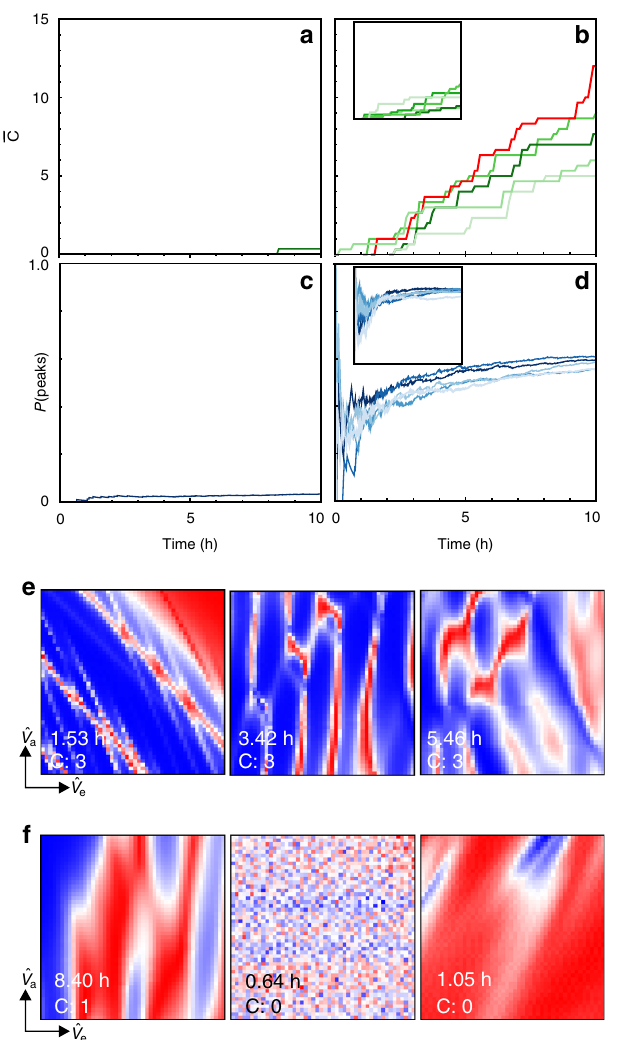
Fig. 5 Algorithm ’ s performance. a – d Average number of current maps displaying double quantum dot features, (cid:2) C , and P (peaks) as a function of laboratory time. Current maps are labelled by humans a posteriori, i.e., after the algorithm is stopped. a , c , b , d correspond to one run of Pure random and fi ve runs of our algorithm, respectively. All algorithm runs displayed in main panels were performed in Device 2, while insets show runs of our algorithm in Device 1. e , f High resolution current maps measured in Device 2 by Pure random and one of our algorithm runs, respectively. We indicate the time the algorithm had been running for before they were acquired and the number of labellers, C , that identi fi ed them as displaying double quantum dot features. Current maps are ordered from left to right in decreasing order of C , and maps that have the same values of C are displayed in the order at which they were sampled. Each panel uses an independent colour scale running from red (highest current measured) to blue (lowest